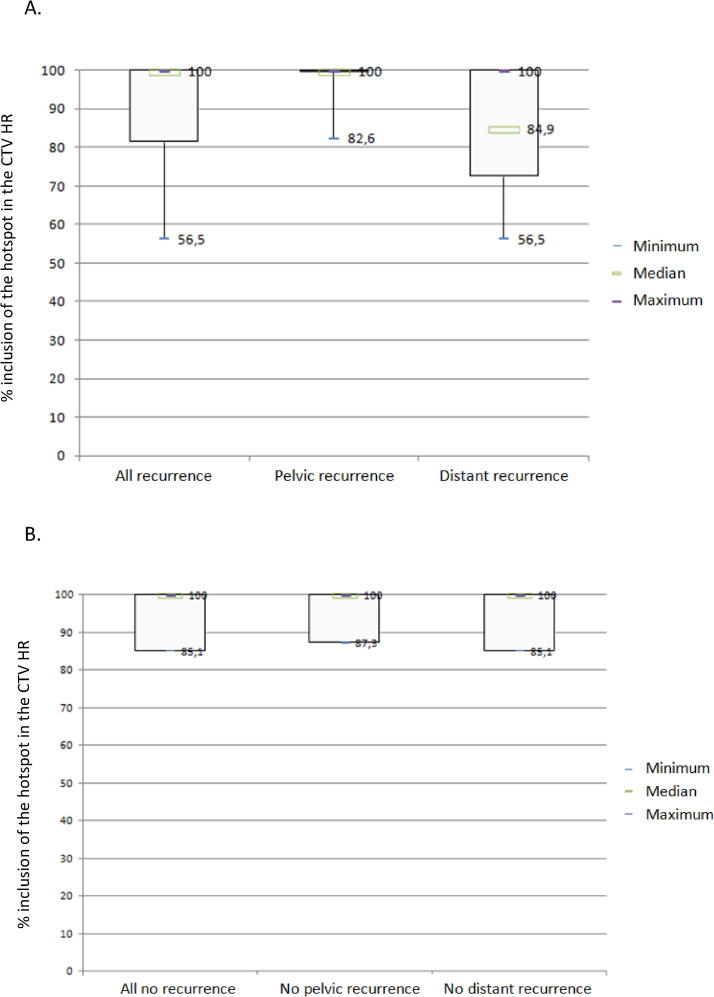
Box plots representing the inclusion of the hotspot in the CTV HR (A) in the recurrence group and (B) in the non recurrence group, with a significant difference observed between patients with and without distant recurrence (p < 0.0001), but without difference between the other subgroups.